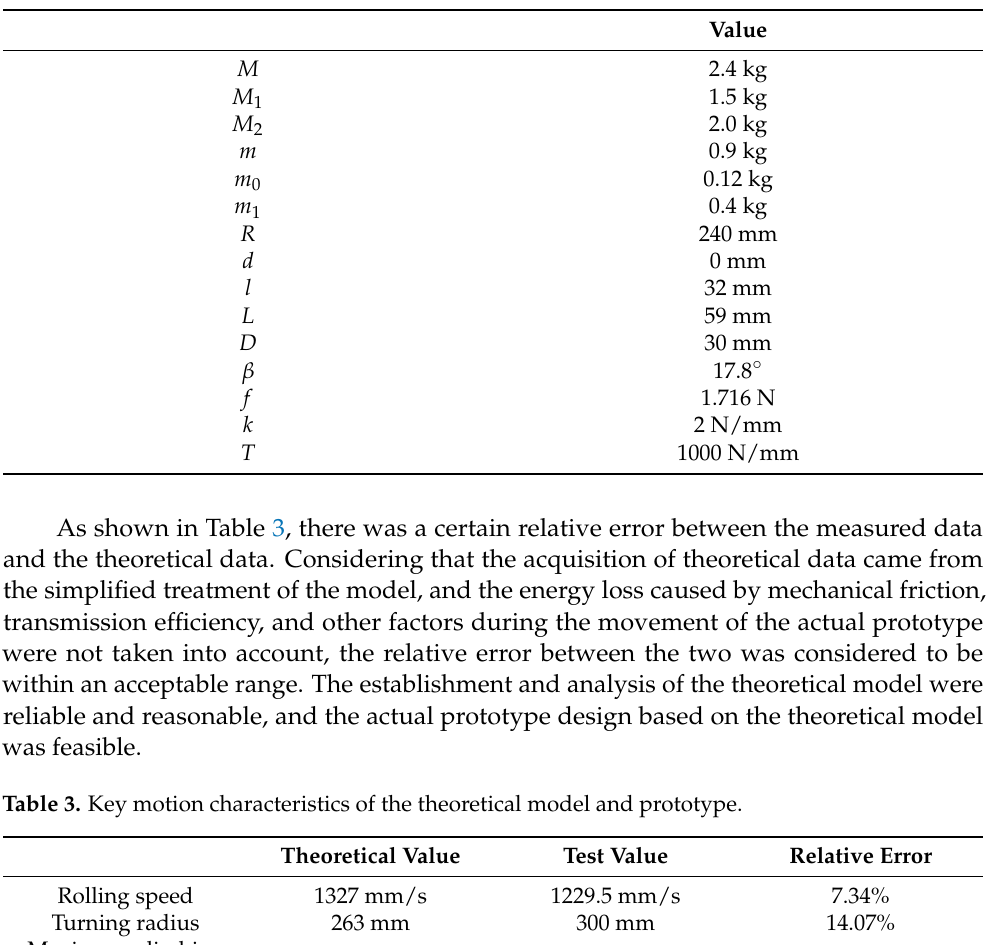
Table 2. Parameters of the prototype.